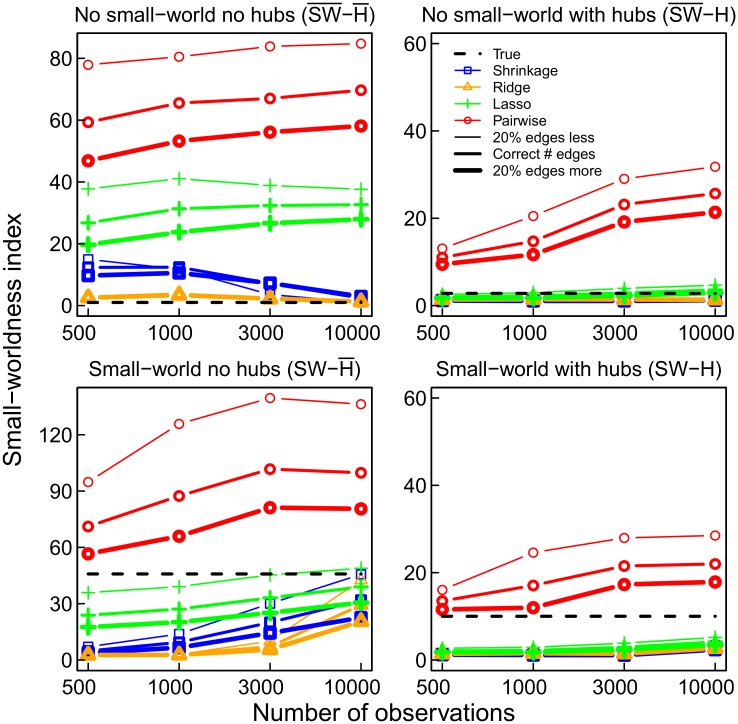
The small-worldness index for the four networks and the four estimation methods pairwise correlations (red), lasso (green), ridge (orange), and shrinkage (blue), compared to the true value −− (black).The thickness of the line represents the number of selected edges. Pairwise correlation networks always overestimate the small-worldness.